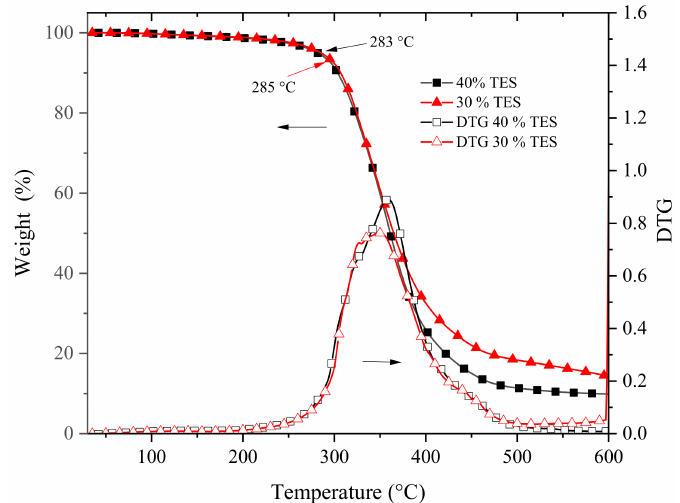
Figure 7. Comparison of the thermograms of the crosslinked polymers derived from the photocurable formulation of the epoxy resin with 40 mol % of TES and 30 mol % of TES.